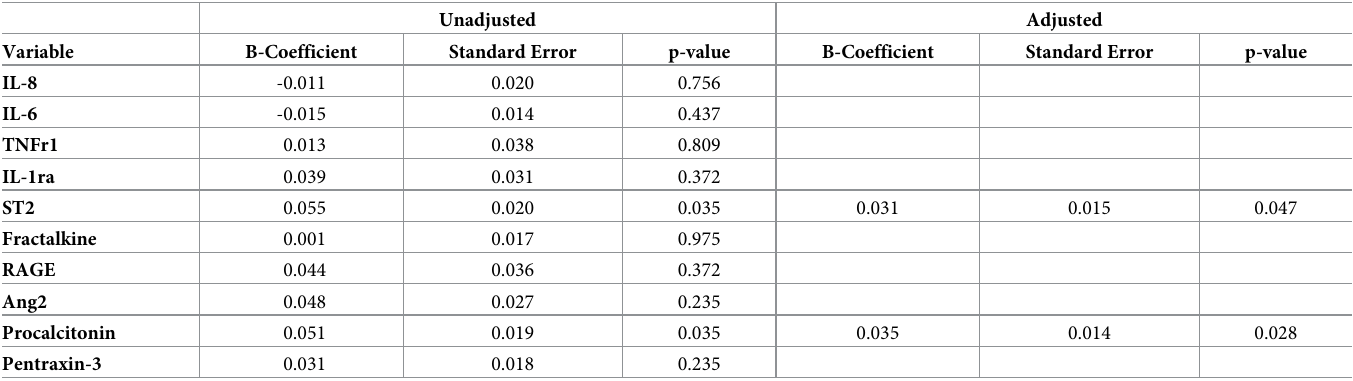
Table 3. Unadjusted and adjusted associations of host response biomarkers with average glucose over the first two days of ICU